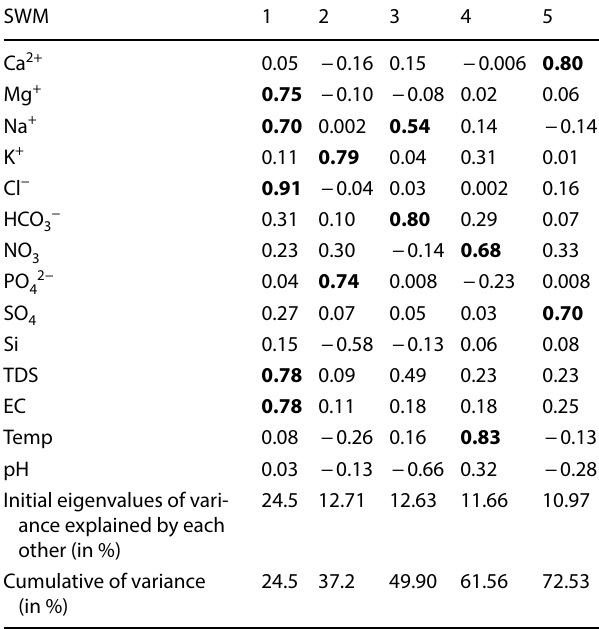
Table 7 Factor scores of GW samples and varimax factor matrix of chemical constituents during SWM (numbers in bold indicates the positive loadings of the parameters in the